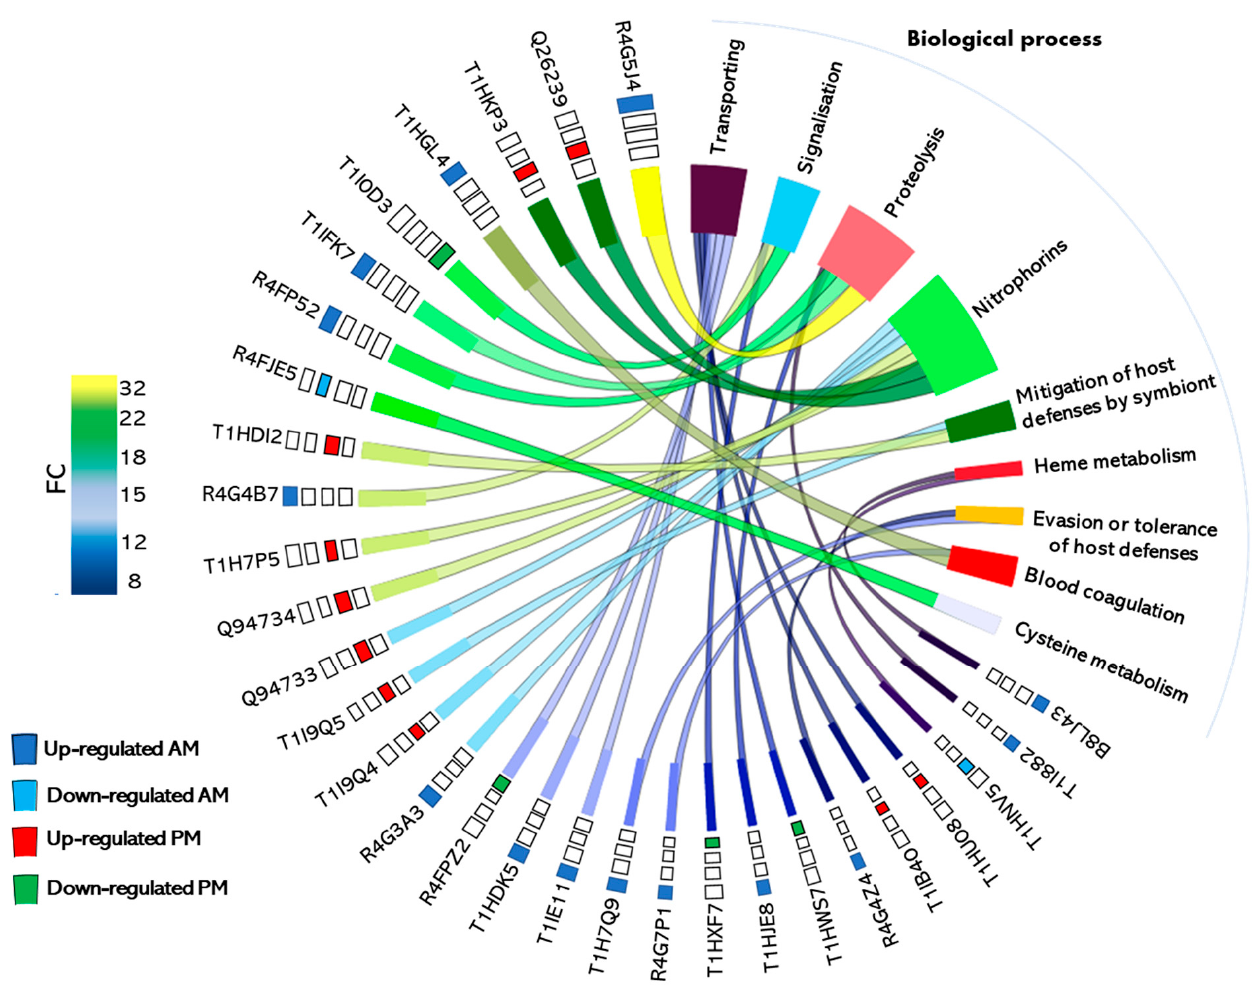
Figure 3. Chord diagram presenting top ranked differentially regulated proteins in R. prolixus midgut tissues in response to blood feeding. Proteins are linked to their assigned biological process via colored ribbons. Proteins are ordered according to the calculated fold-change (FC), which is displayed in descending color intensity with a cut-off fold-change ≥ 8.